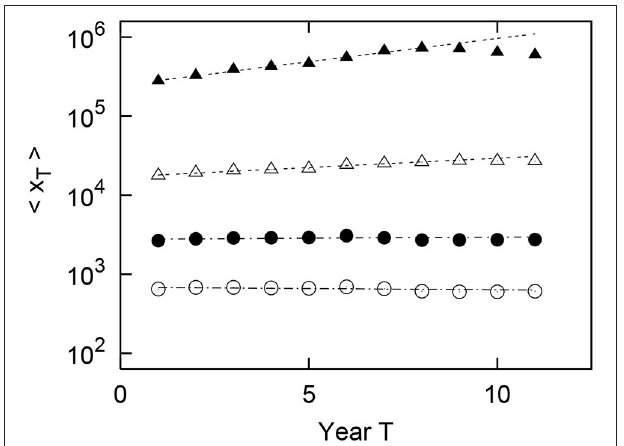
FIGURE 9 | Geometric mean growth of the urban population in Italy from 1901 to 2001 ( T = 1,2, ··· ,11). The original population of x 1 in 1901 ( T = 1) is divided into logarithmically equally sized bins: x 1 ∈ [10 m + 1 ,10 m + 2 )